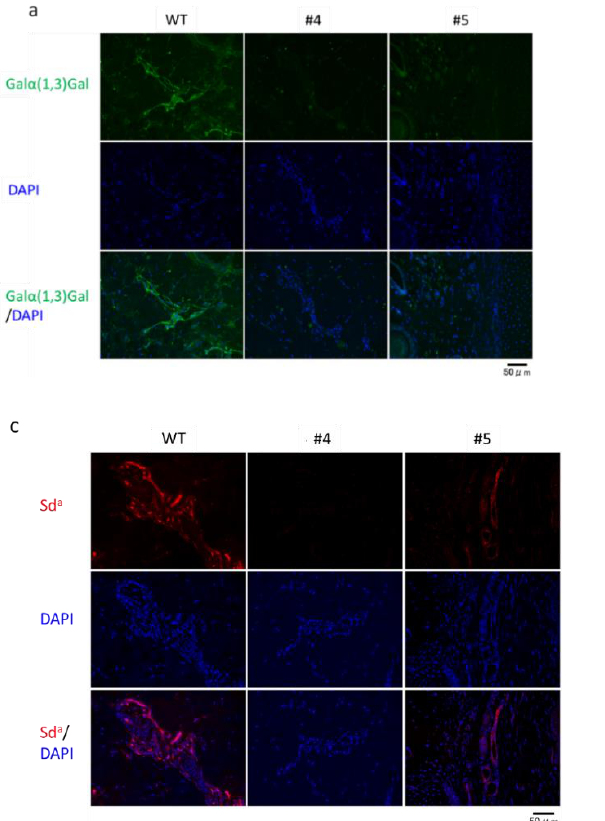
Figure 6. Immunohistochemical assessment of wild-type, GGTA1 / B4GALNT2 double-edited (#4), and GGTA1 / CMAH/B4GALNT2 triple-edited (#5) piglets. The ear biopsies derived from wild-type (WT) and mutant piglets (#4 and #5) were immunohistochemically stained for Galα(1,3)Gal (green) ( a ), Neu5Gc (green) ( b ), and Sd a (red) ( c ). These tissues were counterstained with 4', 6-diamidino-2-phenylindole (DAPI) (blue). The scale bar in each panel represents 50 μm.